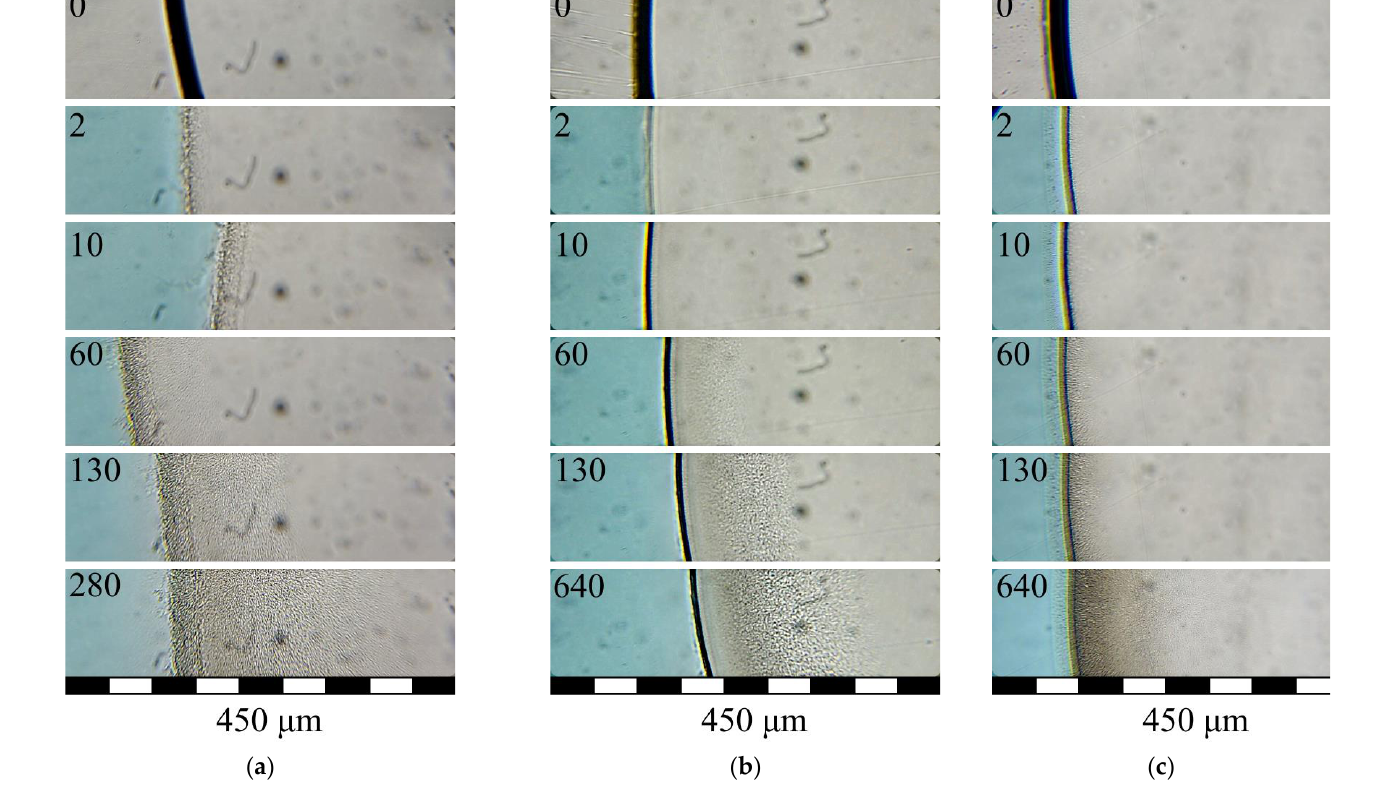
Figure 6. Photographs illustrating the evolution of the structure of PLGA/TG mixtures containing ( a ) 10, ( b ) 20, and ( c ) 30 wt.% polymer upon their contact with the nonsolvent (stained water mixed with TG in the 1:1 ratio). Indicated in the top left corner of each photograph is the time elapsed after the sample mixture came into contact with the nonsolvent.